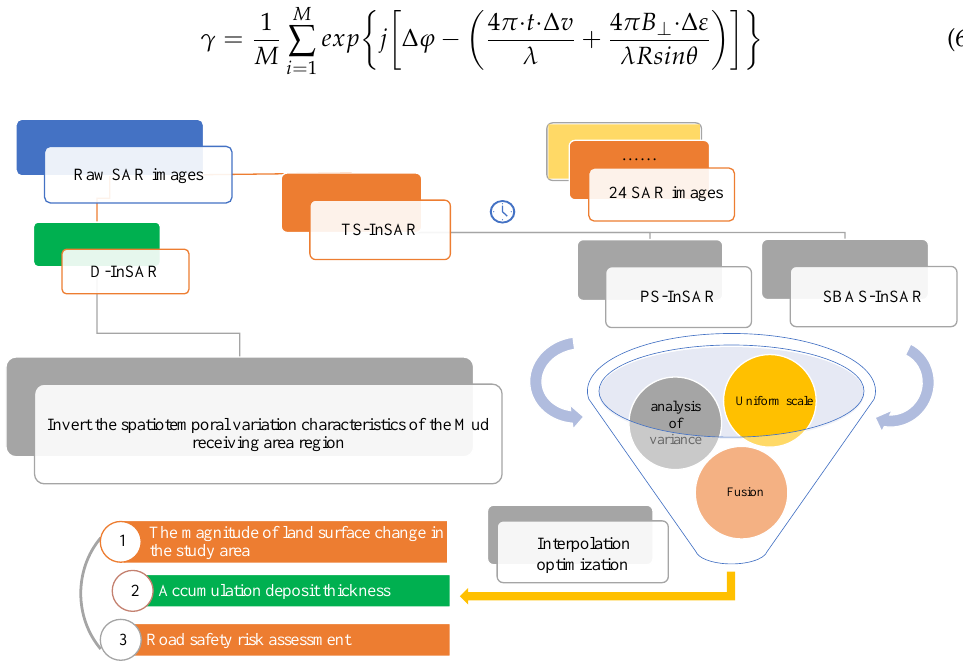
Figure 3. D-InSAR and TS-InSAR processing flow and product optimization processing method.